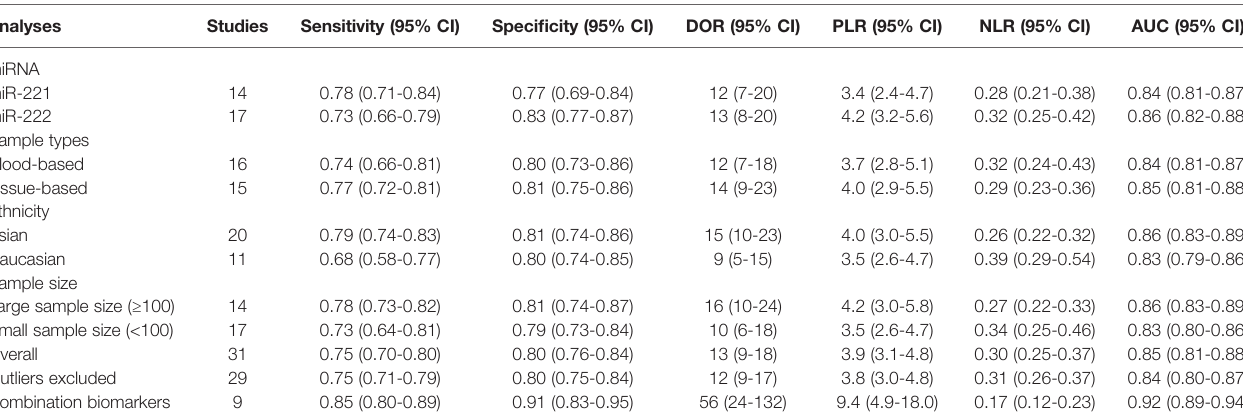
TABLE 2 | Summary table of the diagnostic accuracy of miR-221/222 for